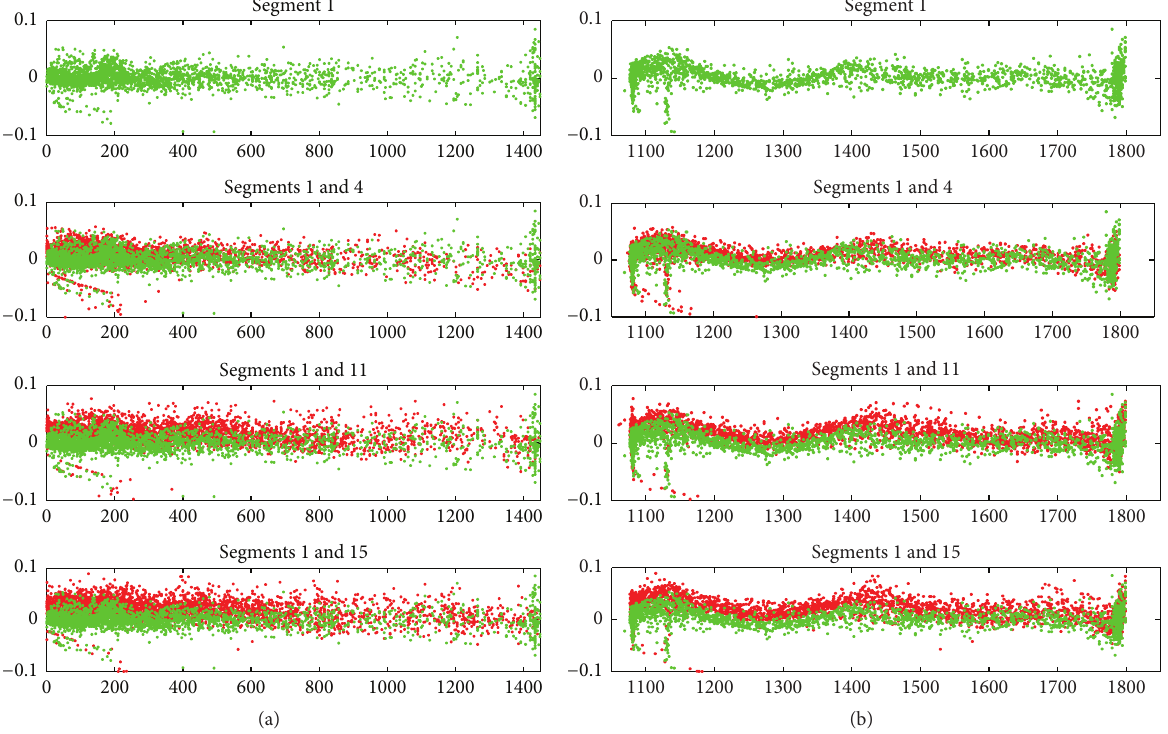
Figure 8: Regression of RMS estimation error on segment 1 (green) and selected following segments (red) in function of power (a) and rotational speed